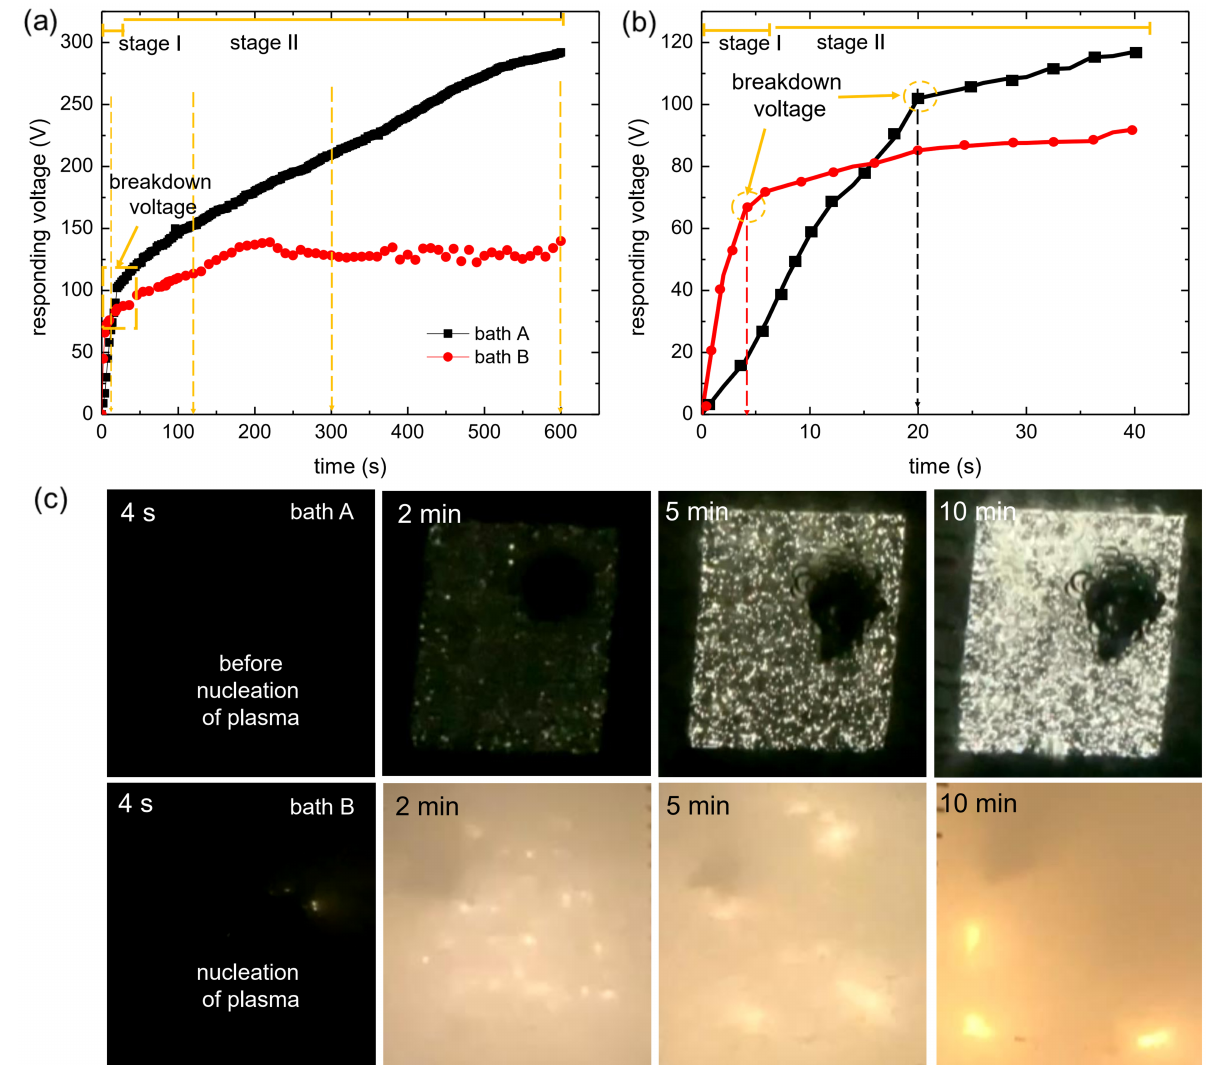
Figure 1. ( a ) Responding voltage vs. coating time curves of the samples treated in in ( a ) low concentra- tion (bath A), and high concentration (bath B) aluminate solution. ( b ) High magnification of ( a ) showing breakdown of the passive film at different voltage and coating time. ( c ) Evolution of plasma discharges formed on the surface of Cp-Ti with respect to coating time in bath A and bath